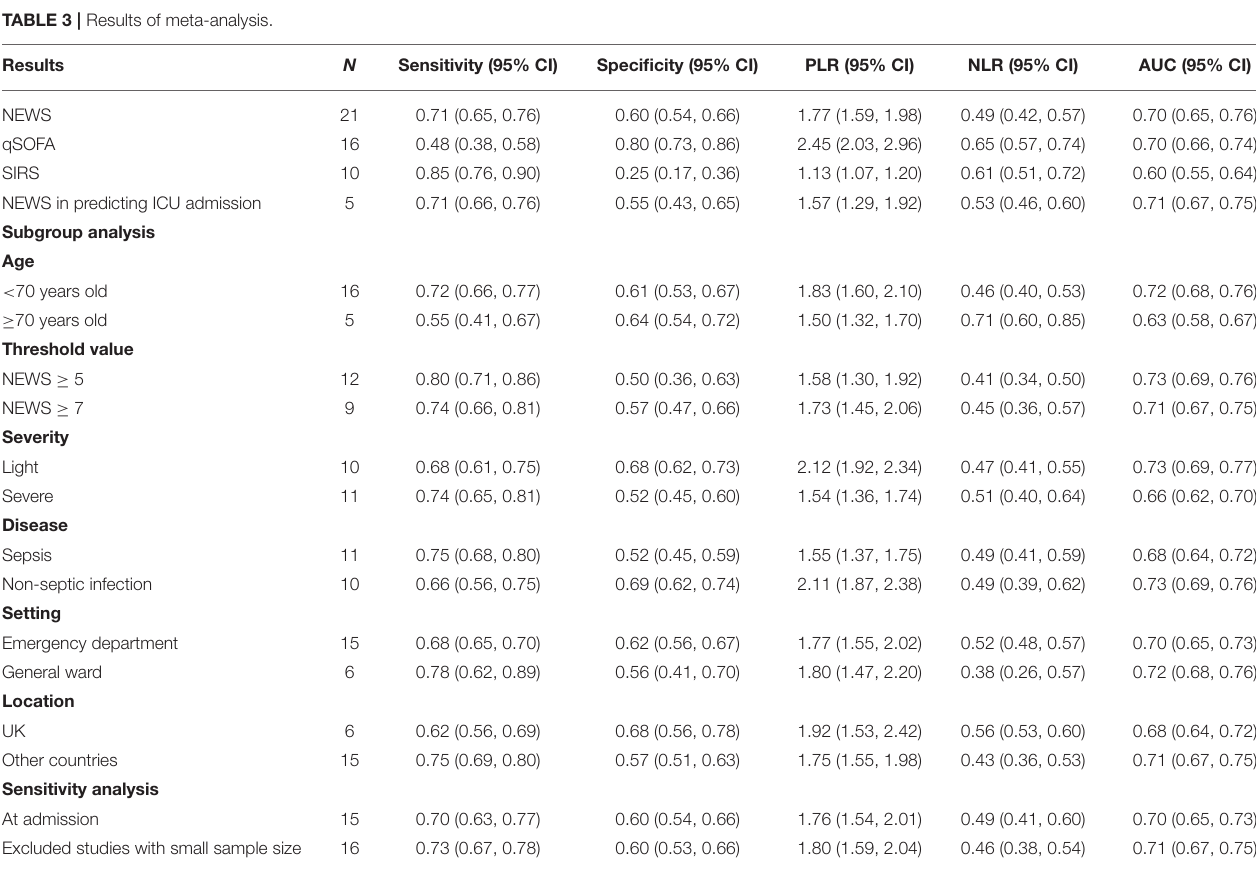
TABLE 3 | Results of